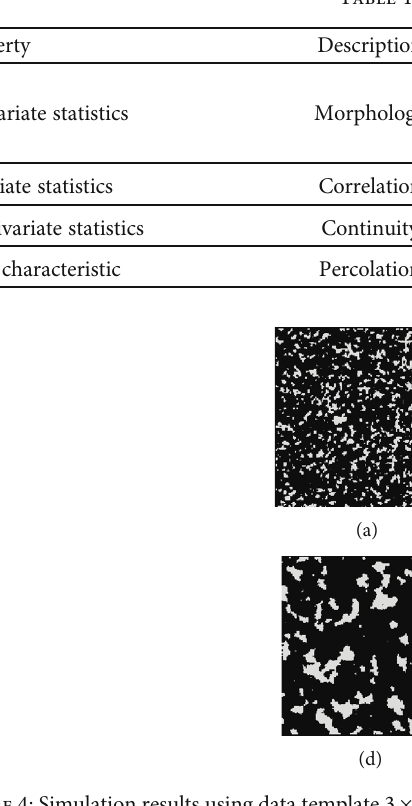
Figure 4: Simulation results using data template 3 × 3 , 11 × 11 , and 19 × 19 with single- and multiple-grid schemes. (a – c) Single-grid results. (d – f) Multiple-grid results.